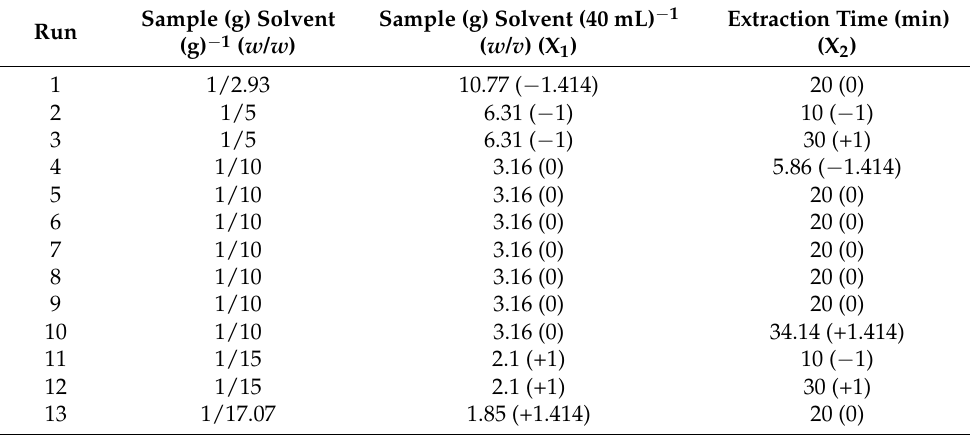
Table 8. Rotatable central composite design in the coded A and uncoded form of the independent variables (X 1 and X 2 ) for cold ethanol extraction at different temperatures ( − 20 ◦ C, − 40 ◦ C, and room